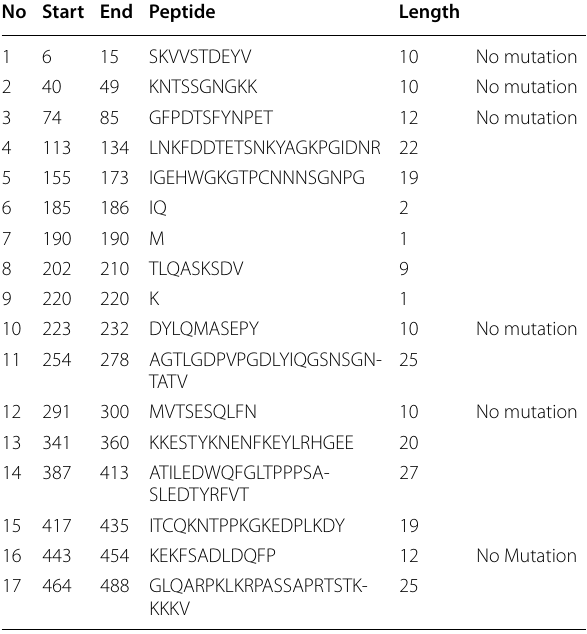
Table 3 Some B cell epitopes prediction.